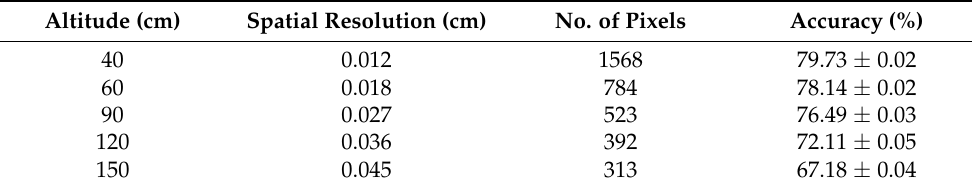
Table 2. Determining accuracy for different sample size of